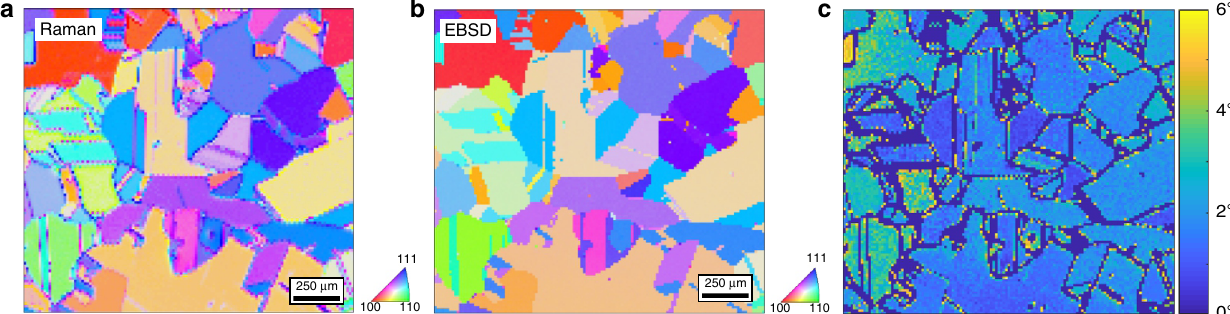
Fig. 3 2D-SAROM results for Si. a 2D-SAROM and b EBSD orientation maps of the surface of a polycrystalline Si sample. The colors refer to the orientations shown by the inverse pole fi gures (inserted). Both, SAROM and EBSD orientation maps have a step size of 13.51 µ m, a map dimension of 131 × 120 pixels or 1770 × 1620 µ m and an exposure time per step of 60 ms. c misorientation map between SAROM and EBSD